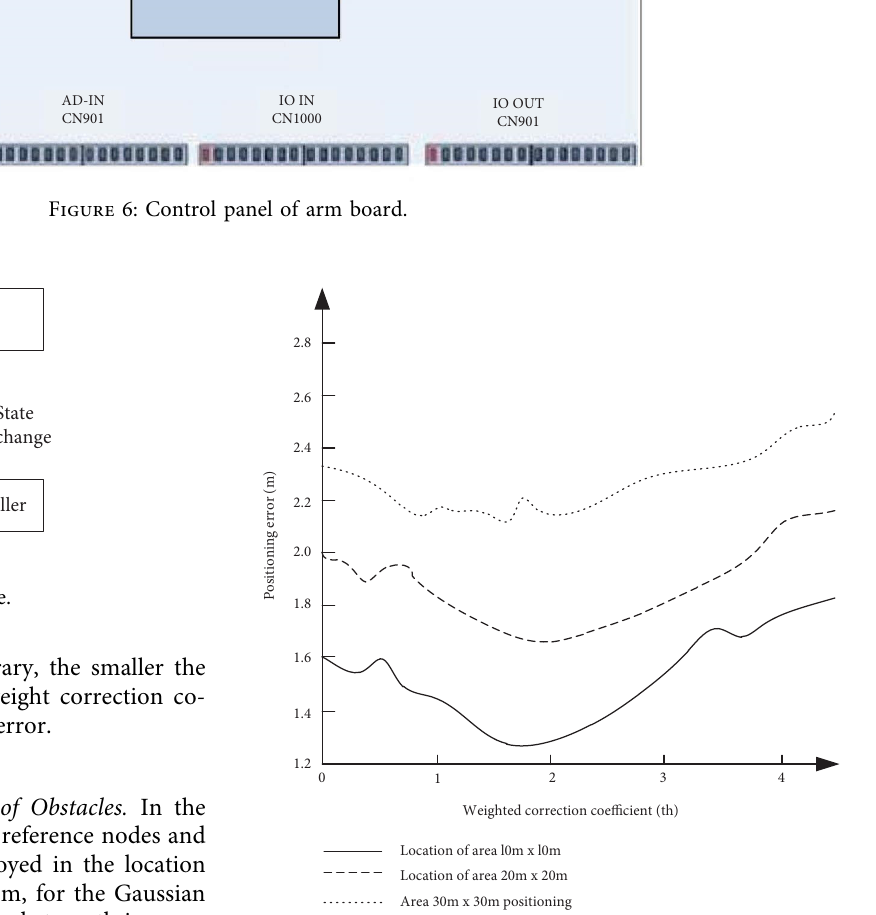
Figure 8: Impact diagram of location area